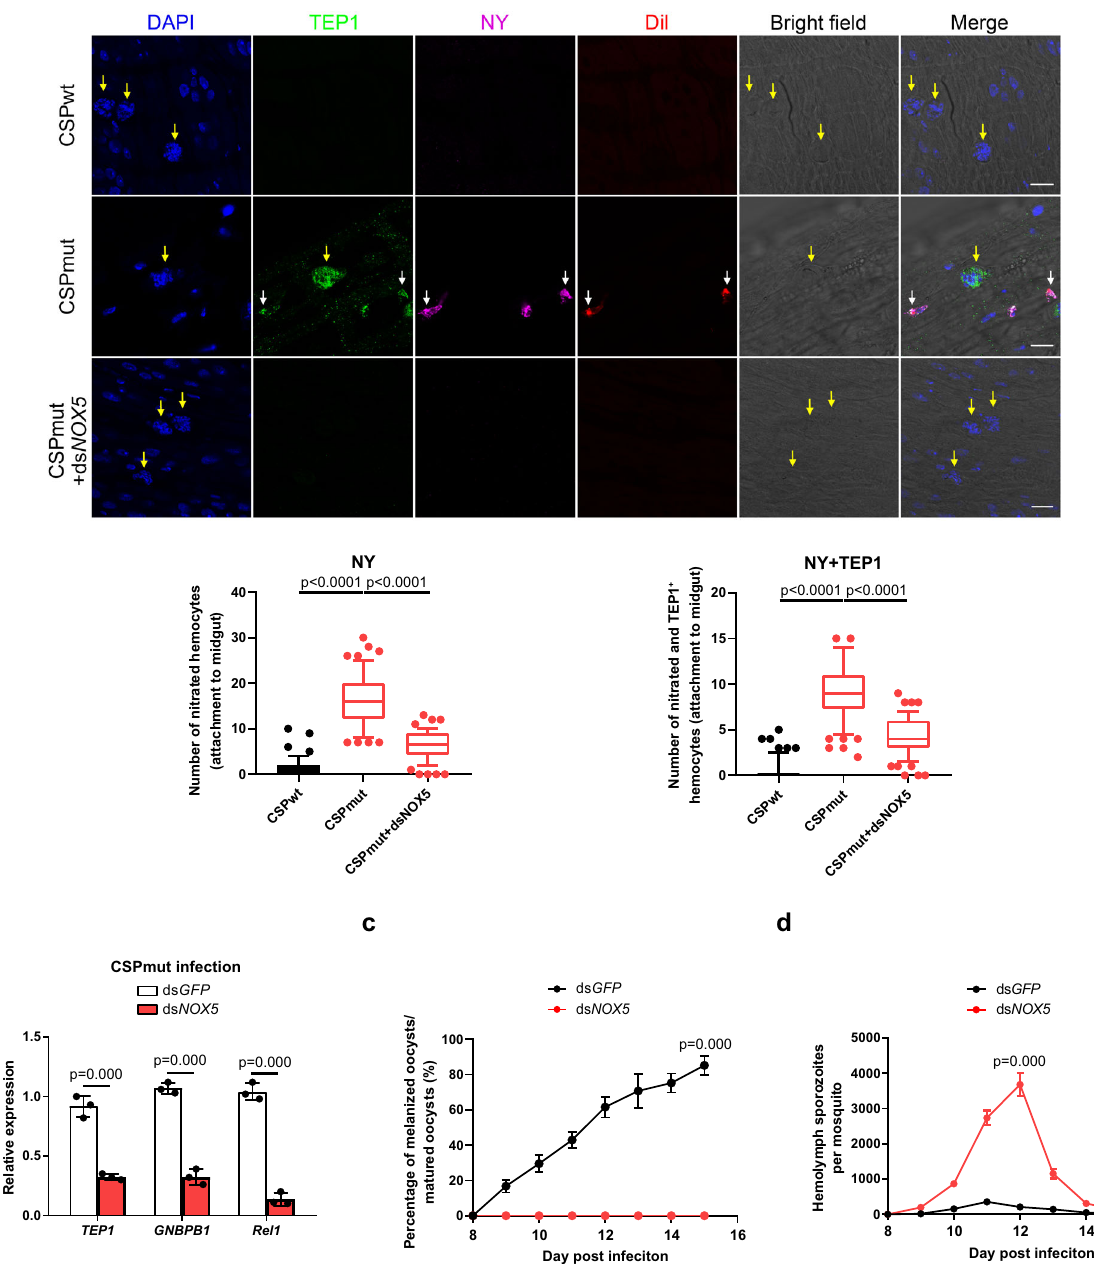
Fig. 4 CSP mut triggers mosquito immune responses through the induction of hemocyte nitration. a Representative image of the nitration and TEP1 expression of hemocytes around oocysts in Plasmodium yoelii CSP wt or CSP mut parasite-infected mosquitoes at day 4 after NOX5 was knocked down or not. This was determined by the detection of nitrotyrosine (NY), TEP1, and Vybrant CM-DiI (Dil); scale bar 50 μ m (upper), and the numbers of nitrated hemocytes and TEP1-positive nitrated hemocytes attached to midguts ( n = 60) were statistically analyzed (low). Yellow arrow indicates either WT or mutant oocysts; white arrow indicates hemocytes. b The relative expression of TEP1 , GNBP-B1 , and Rel1 in P. yoelii CSP mut parasite-infected mosquitoes ( n = 15) at day 5 PI after NOX5 knockdown. c The percentage of melanized mature oocyst in P. yoelii CSP mut parasite-infected mosquitoes ( n = 36) at the indicated time points after NOX5 knockdown. d The average number of hemolymph sporozoites in P. yoelii CSP mut parasite-infected mosquitoes ( n = 45) at the indicated time points after NOX5 knockdown. For box-plot diagram ( a ): middle line represents median; boxes extend from the 25th to 75th percentiles. The whiskers mark the 10th and 90th percentiles. a , b A two-sided Student ’ s t -test was used for the statistical analysis. c , d A two-sided Mann – Whitney U test was used for the statistical analysis. The data were presented as the means± SD; ns, no signi fi cance; p -values were shown. The data were combined based on three independent experiments ( a – d ). Source data are provided as a Source Data fi